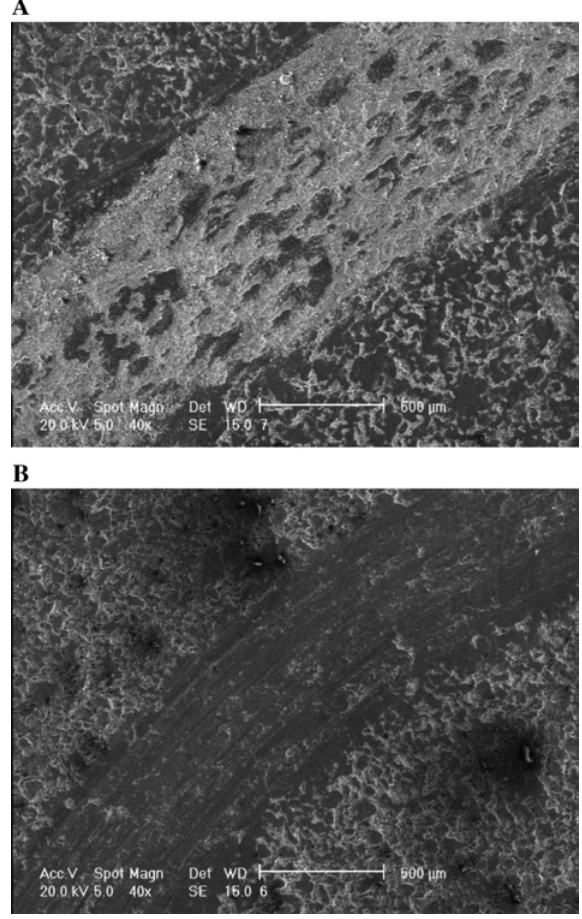
Figure 10: The SEM micrographs for worn surface of (A) CuFe alloy and (B) CuFe(alumina)